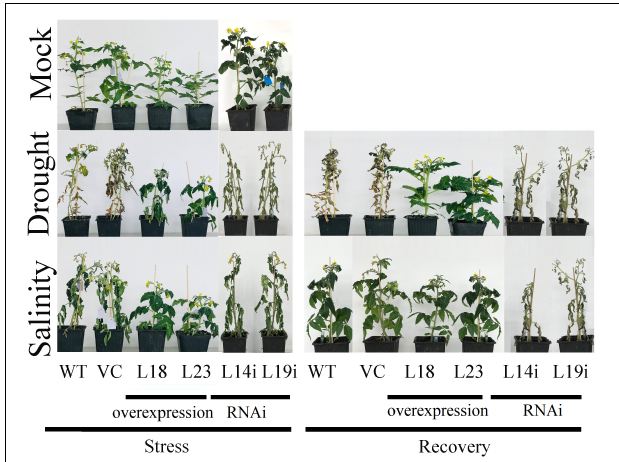
FIGURE 4 | Drought and salinity assay. Phenotypes obtained after 30 days drought and 18 days salinity stress and recovery from drought and salinity for 10